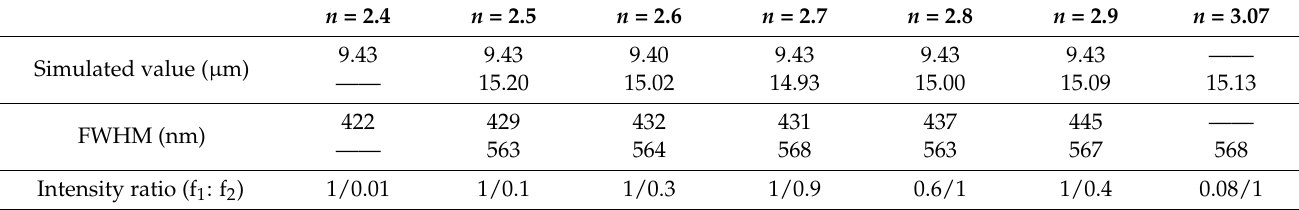
Figure 7. Simulated intensity results along z-axis when the refractive index of BTO changed.